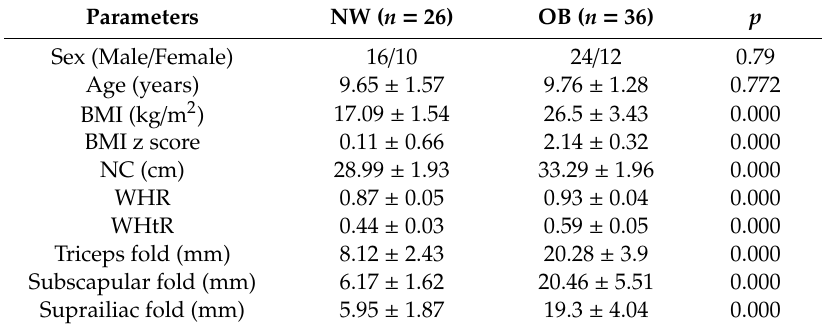
Table 1. Demographic and anthropometric characteristics between non-overweight and obese children.